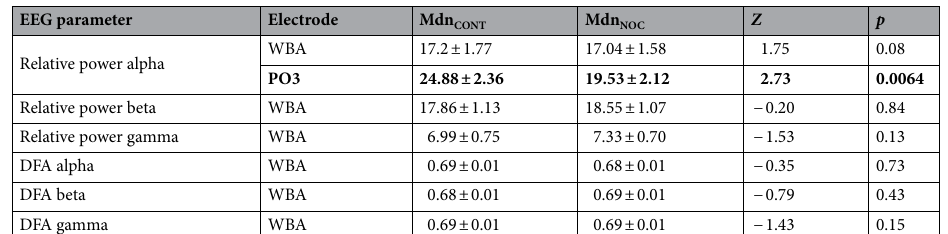
Table 1. Summary of statistics for differences in EEG parameters between nocebo and control trials during conditioning shown in Fig. 2. Wilcoxon signed-rank tests were performed on the whole-brain average per subject (computed as mean of all electrodes). Rows show EEG parameters, columns show the median whole- brain average value across subjects for control and nocebo trials, Z - and P -value corresponding to the signed- rank test. The median EEG parameter value for each group is reported with the standard error of the mean. CONT Control trials during conditioning, NOC Nocebo trials during conditioning. Bold font weight indicates significance at P < 0.05.